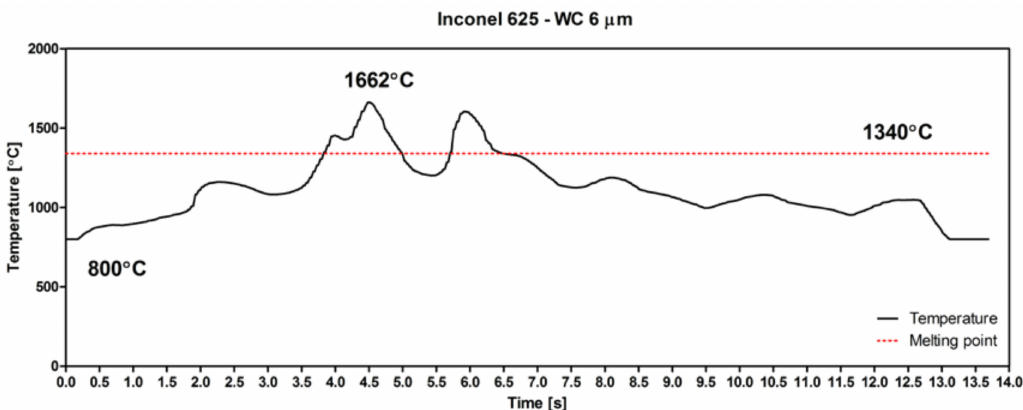
Figure 6. Temperature curve of deposition of a single layer of Inconel 625–WC coating during laser metal deposition.